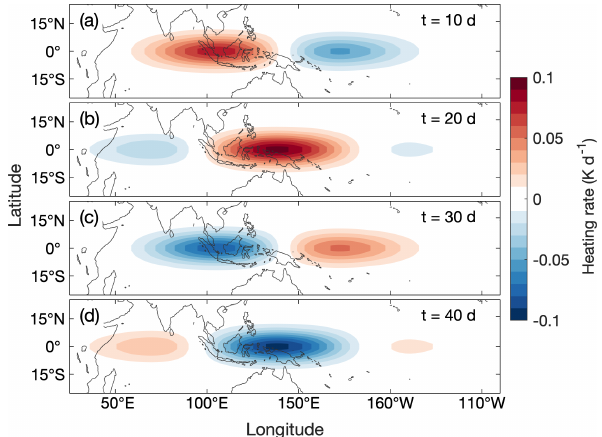
Figure 1. Propagating thermal forcing used in the LBM simulations at t = (a) 10d, (b) 20d, (c) 30d, and (d)